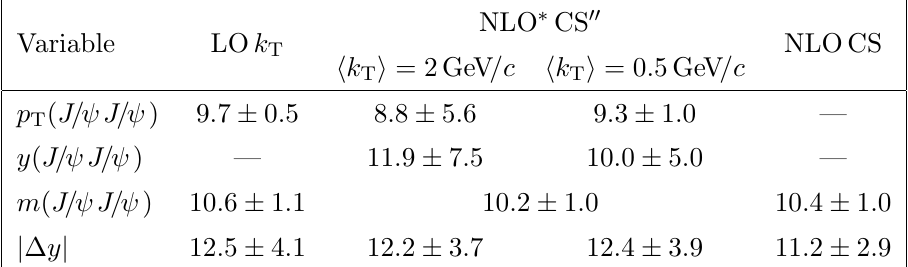
Table 3 . Percentages of the DPS component, f DPS , determined with the simple two-component (cid:12)t to di(cid:11)erent distributions for di(cid:11)erent SPS models.